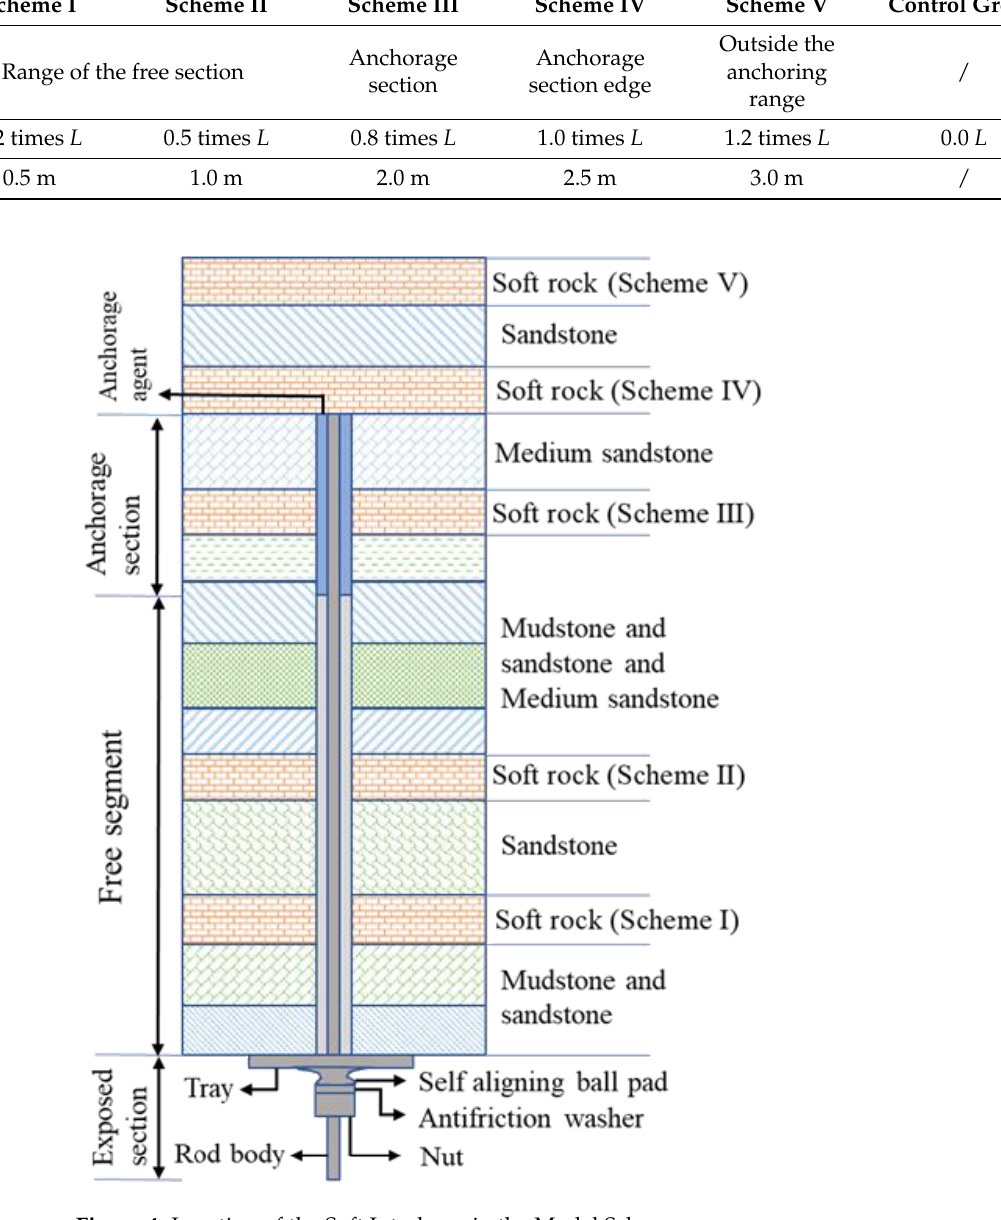
Figure 4. Location of the Soft Interlayer in the Model Scheme. Table 2. Model Scheme.